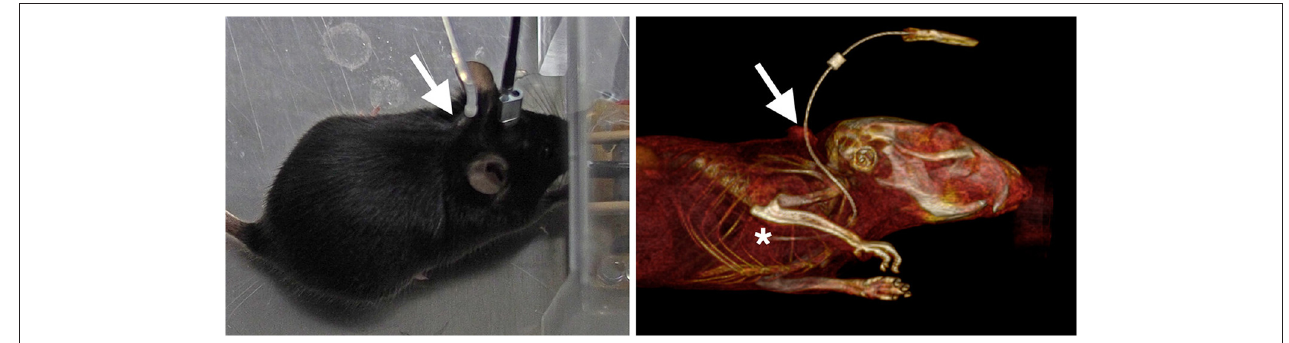
FIGURE 4 | Images of mice implanted with chronic external jugular vein catheters. The image on the left shows a mouse during optogenetic stimulation, the image on the right a volume-rendered CT from a mouse that was injected with an X-ray-dense contrast agent during CT acquisition. The arrows point to the dorsal exit of the catheter. The subcutaneous part of the tunneled catheter can be seen in the CT. The tip of the catheter (asterisk) is at or close to the right